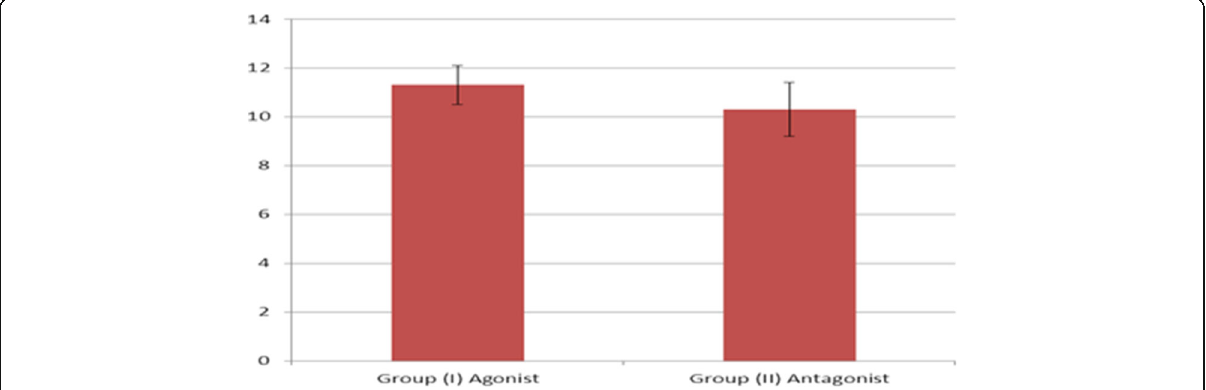
Fig. 2 Box plots representing the median and IQR values for the durations of stimulation in both